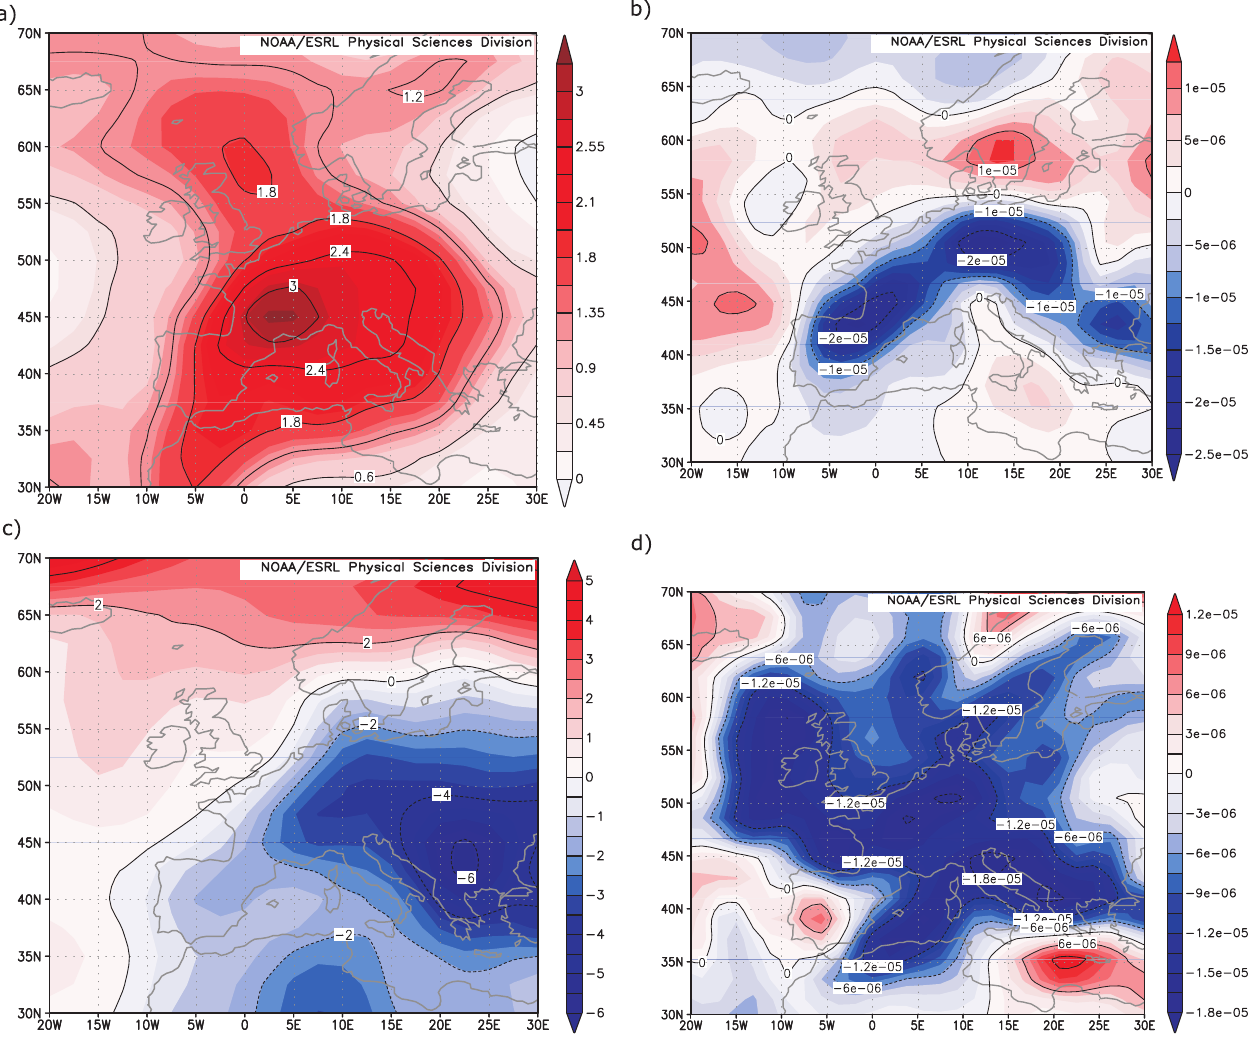
Fig. 3. Spatial distribution of 2003 spring-summer (MJJA) air temperature (a) and precipitation anomalies (b) relative to 1968–1996 and the anomalies of the most extreme months in 2003; February for low temperature (c) , March for low precipitation (d) . Images were provided by the NOAA-CIRES (taken from Climate Diagnostics branch, Boulder, Colorado